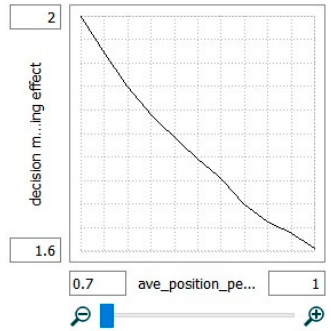
Figure A2. Decision-making effect non-linear graphical function, explaining: as the average position percent decreases (more part-time work), the decision-making effect increases (which increases the sick